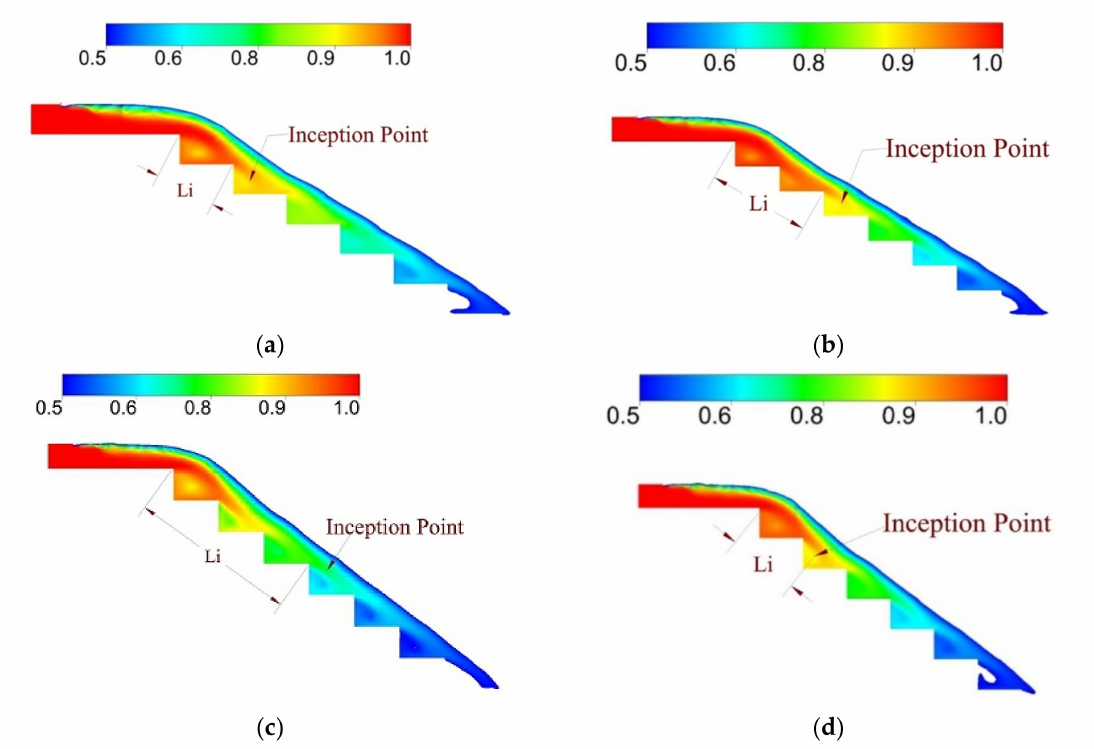
Figure 6. Water volume fraction contours of stepped spillway models with slopes of 29 ◦ and 35 ◦ at different discharge rates; ( a ) 29 ◦ model with discharge of 0.625 m 2 /s; ( b ) 29 ◦ model with discharge of 0.75 m 2 /s; ( c ) 35 ◦ model with discharge of 0.625 m 2 /s; ( d ) 35 ◦ model with discharge of 0.75 m 2